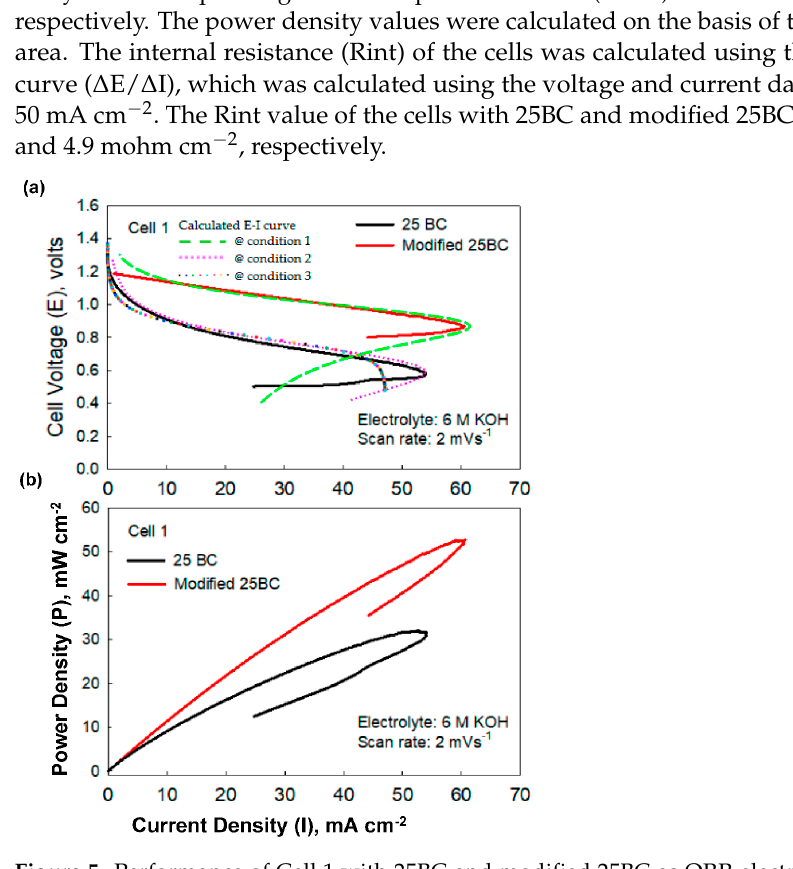
Figure 5. Performance of Cell 1 with 25BC and modified 25BC as ORR electrode: ( a ) plots of cell voltage versus current density (E–I) curves. ( b ) plots of power density versus current density (P-I) voltage versus current density (E-I) curves. ( b ) plots of power density versus current density (P-I) curve. In figure (a), the dashed curves of condition 1, the E–I curve was calculated using the COM- SOL electrolysis module, and a reversible reaction was assumed with the Butler–Volmer equation. curve. In figure ( a ), the dashed curves of condition 1, the E-I curve was calculated using the